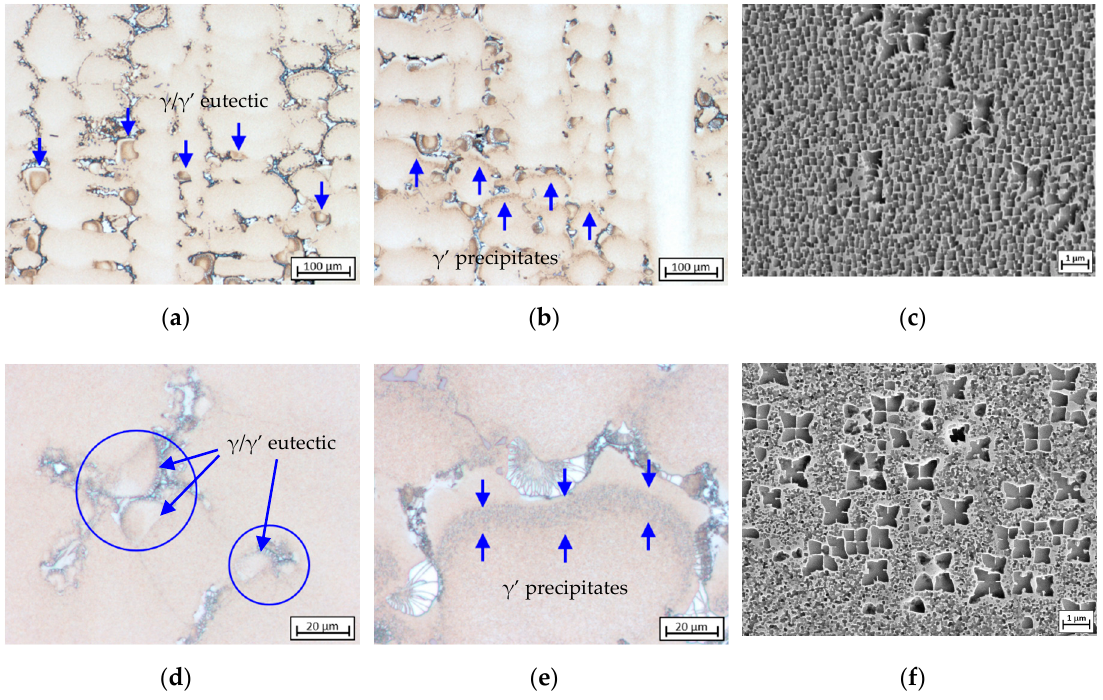
Figure 3. Microstructure images indicating: ( a , d ) γ / γ ’ eutectic formation point; ( b , c , e , f ) the earliest precipitation of γ ’ phase. Images ( a , b , d , e ) represent the LC-MZ sample of CMSX-6+0.03C (W4), ( c ) the CMSX-6+0,03C (W1) and ( f ) MAR-M247 (W1), respectively.